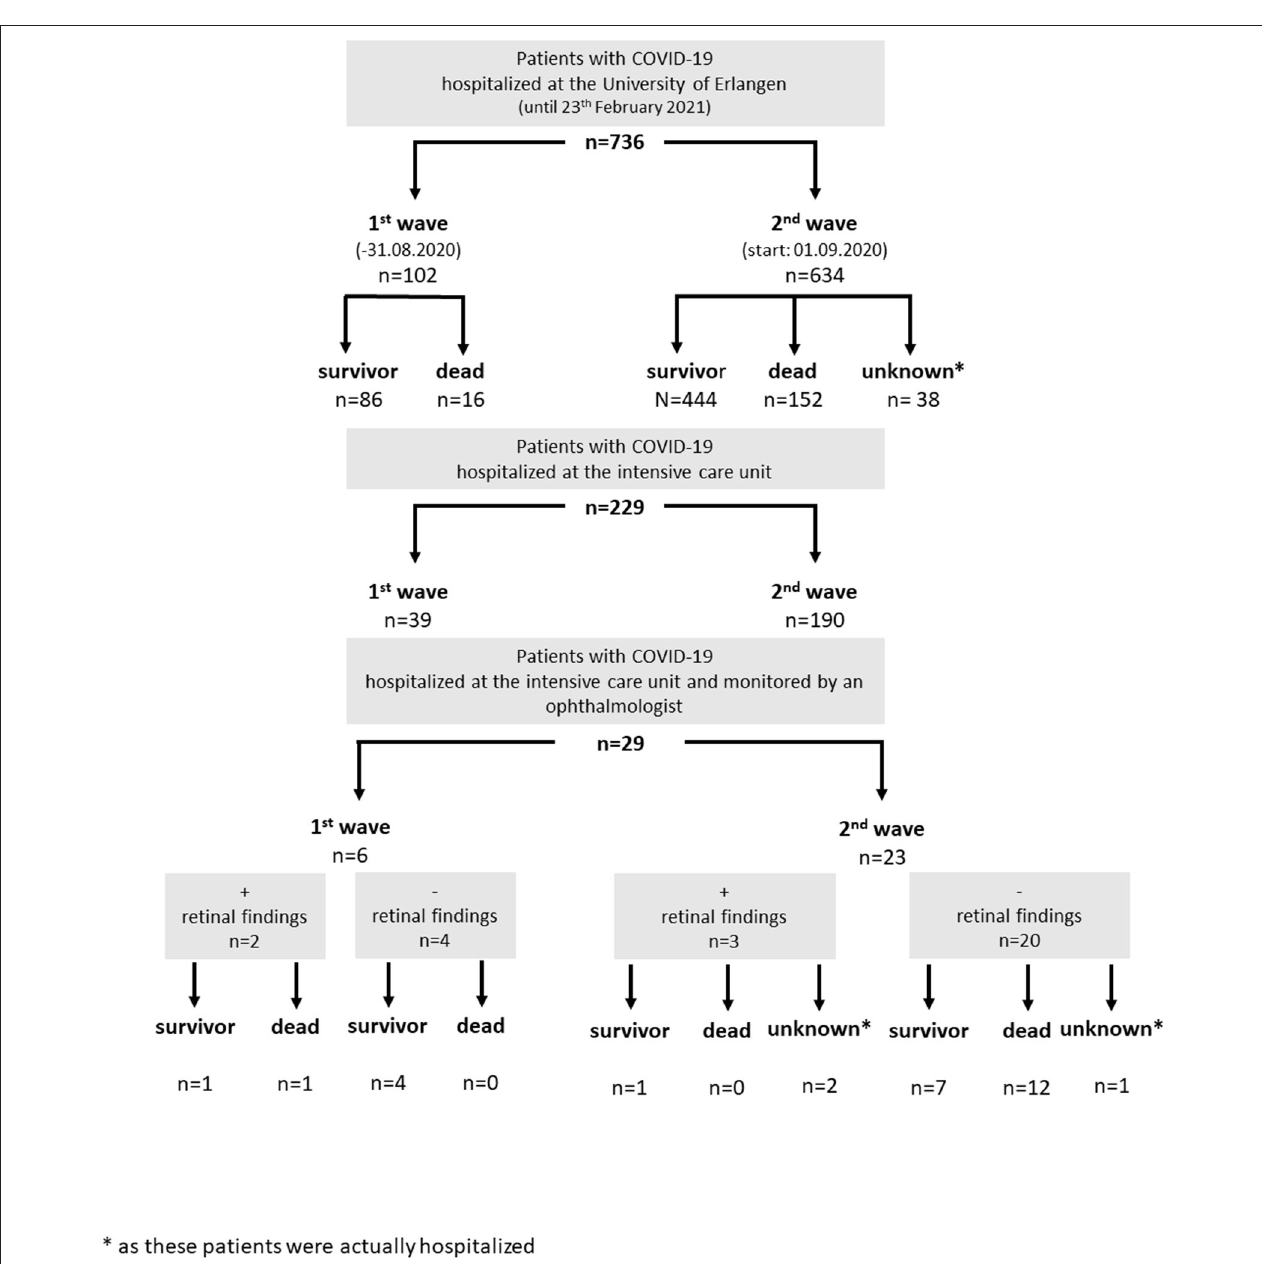
FIGURE 3 | Hospitalized patients with coronavirus disease 2019 (COVID-19) infection at the University of Erlangen (status February 23, 2021): a subgroup of patients of the intensive care unit was monitored by an ophthalmologist for retinal findings (subdivided by their clinical